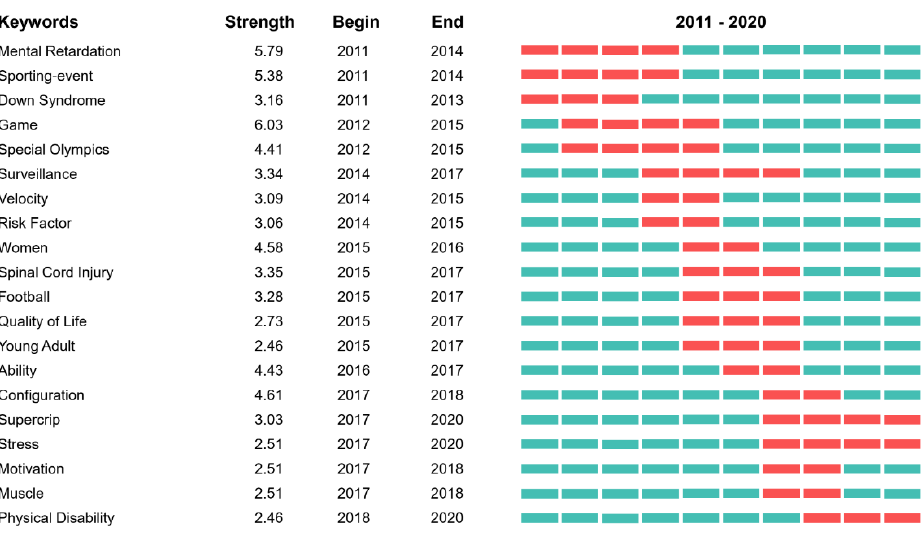
Figure 8. Keywords co-occurrence analysis of adapted sport publications between 2016 and 2020 with timeline.